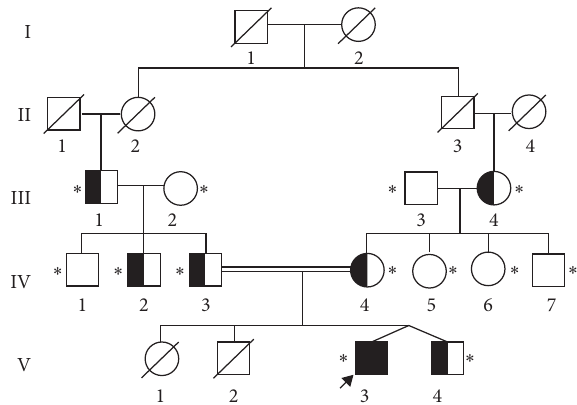
Figure 1: Pedigree of the Chinese family with PHO. PHO is an autosomal recessive genetic disease. The asterisks indicate the members who participated in the study. The arrow indicates the proband. Circles and squares represent females and males, re- spectively. The filled black symbol represents the affected indi- vidual, and the open symbol represents the unaffected individual. The semiblack symbol represents the heterozygous carrier. Double lines represent a consanguineous marriage. Symbol with slash indicates the